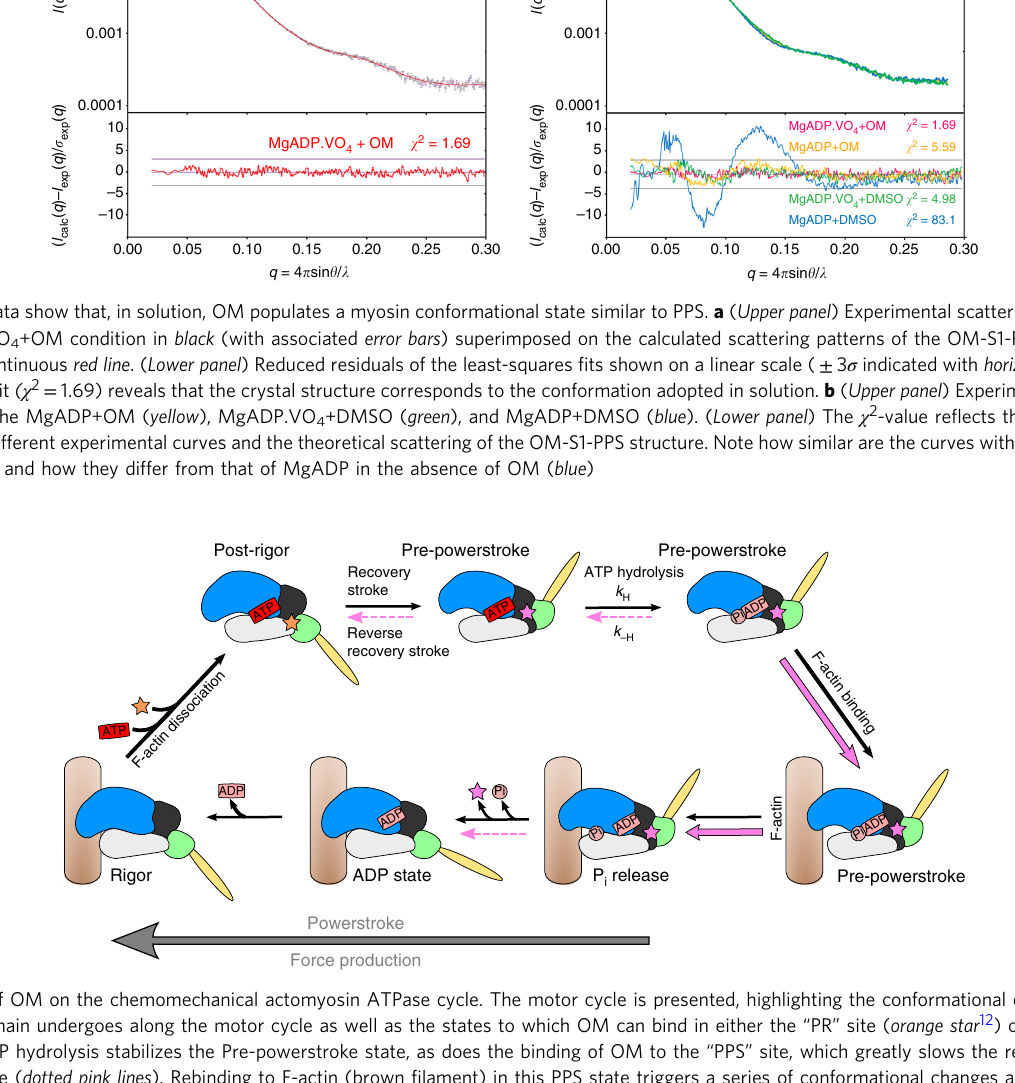
OM dissociates from myosin during the recovery stroke . The two “ PR ” -binding sites and “ PPS ” -binding sites of OM are far away from one another in the pre-recovery and post-recovery stroke structural states (Fig. 1d). This raises the question of whether the drug could remain bound while the motor undergoes the recovery stroke as some binding interactions may not be maintained. In fact, a number of observations indicate that the relocation of the drug from the “ PR ” to the “ PPS ” site may involve drug dissociation. First, the residues that are common in the two binding sites (P710, N711, R712, and L770) make drastically different interactions with the drug in the two binding sites (Supplementary Fig. 1d). Moreover, the orientation of the drug is opposite in the two sites (Supplementary Figs. 1d and 4).